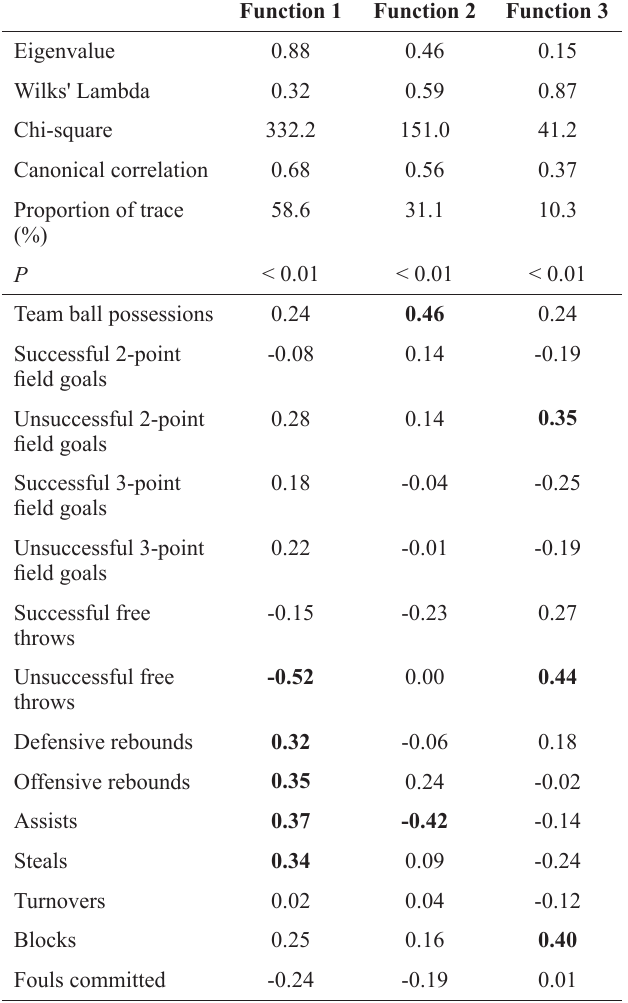
Table 5. Discriminant functions with structural coefficients (SC) for each variable.